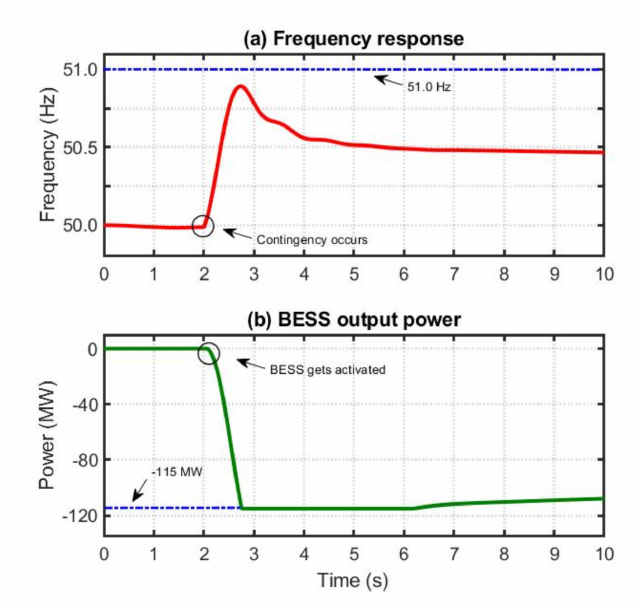
Figure10. FrequencyresponsesandBESSoutputdueto400-MWinterconnectiontripinthree-machinecase.